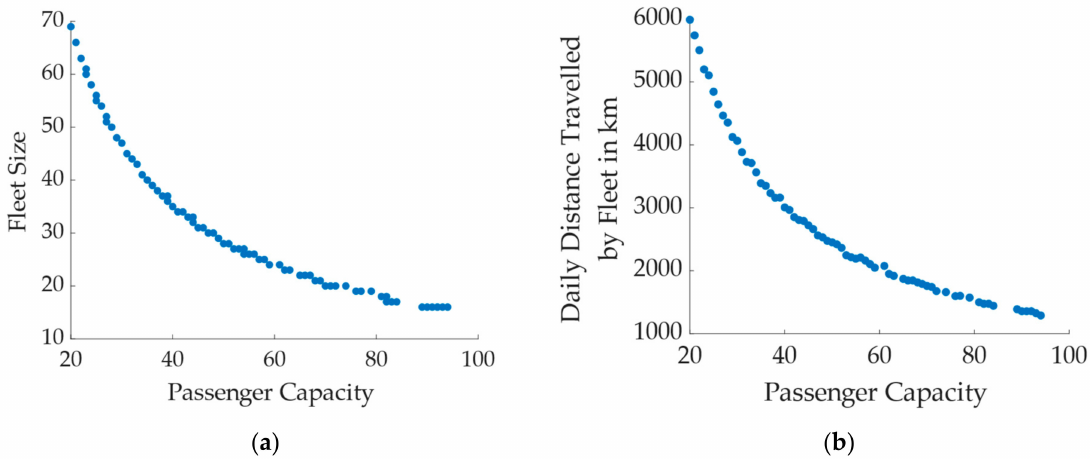
Figure 10. Influence of vehicle size on ( a ) fleet size and ( b ) on distance traveled per day.